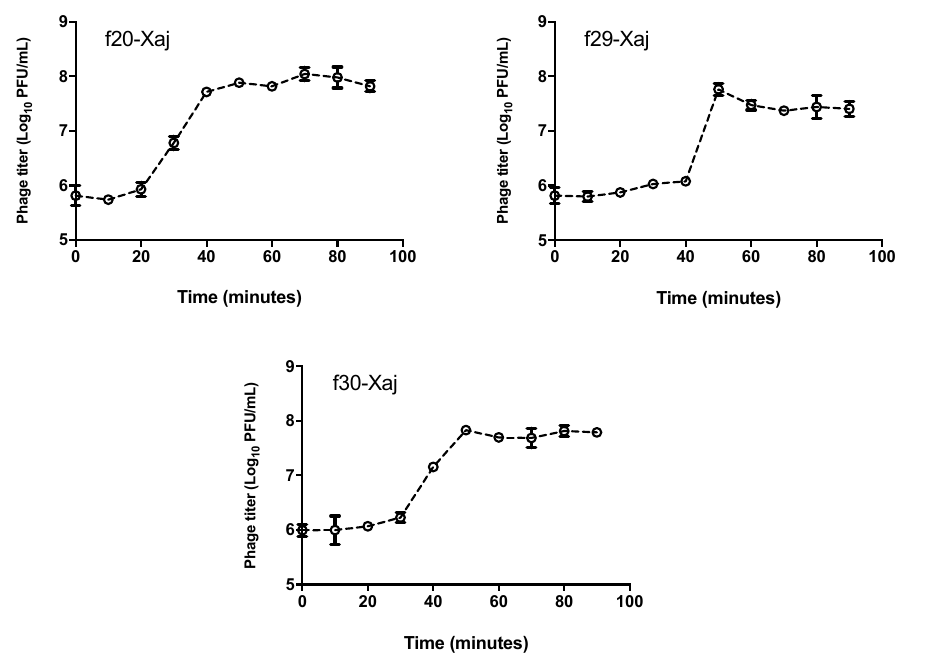
Figure 2. One-step growth curve for bacteriophages f 20-Xaj, f 29-Xaj, and f 30-Xaj propagated in X. juglandis J303. The figure shows means ± standard error from three independent experiments. Table 2. Titer stability of phages under different liquid suspensions and temperatures 28 days post- incubation. This table gathers the results obtained from the three bacteriophages evaluated